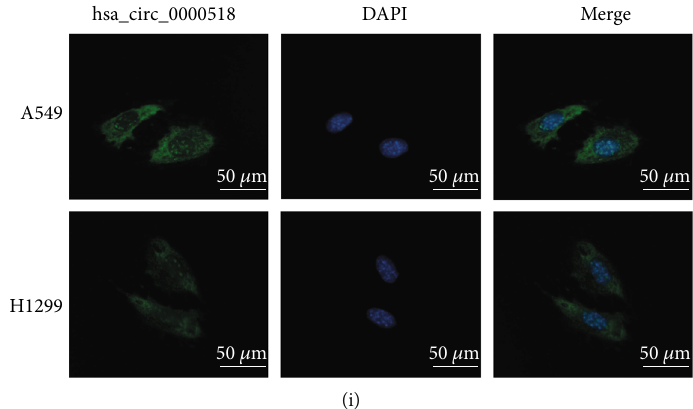
Figure 1: circ_0000518 is relatively highly expressed in NSCLC tissues and cell lines and predominantly localized in the cytoplasm. (a) Gene Expression Omnibus (GEO) dataset analysis of the di ff erent expressions of circ_0000518 between NSCLC and normal tissues. (b) The expression of circ_0000518 was detected by qRT-PCR in NSCLC and adjacent noncancerous tissues. (c) Kaplan-Meier study of the association between circ_0000518 expression and overall survival in patients with NSCLC. (d) The ROC curve was used to assess the possible diagnostic value of circ_0000518; the AUC was 0.7602. (e) circ_0000518 expression in NSCLC cells was detected by qRT-PCR. (f) Chromosomal locations of circ_0000518. (g) qRT-PCR analysis of circ_0000518 and RPPH1 expression levels after treatment with RRPPH1 RNase R. (h) qRT-PCR analysis for the half-life of circ_0000518 after treatment with actinomycin D. ( i) FISH analysis for the localization of circ_0000518. ∗∗ p < 0 : 01 , ∗∗∗ p < 0 : 001